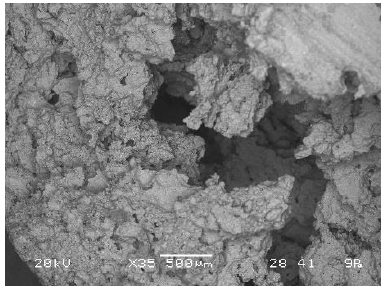
Figure 19. SEM micrograph of AAF prepared with 40 g of mixture ζ 0 , 50 g of precursor, 1% of Na-perborate, and 1% of Na-dodecyl sulphate.